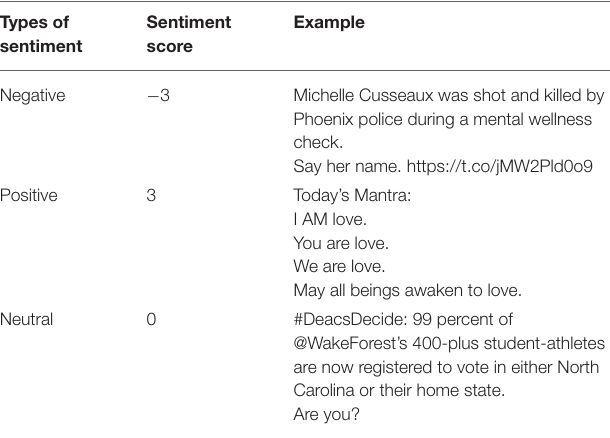
TABLE 1 | Examples of positive, negative, and neutral sentiments and the related sentiment scores generated by the tripartite sentiment